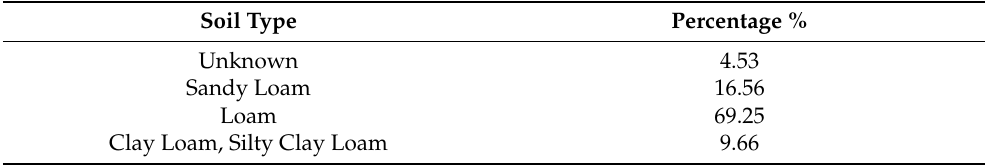
Table 3. The percentage of each soil type of the Hen Chi